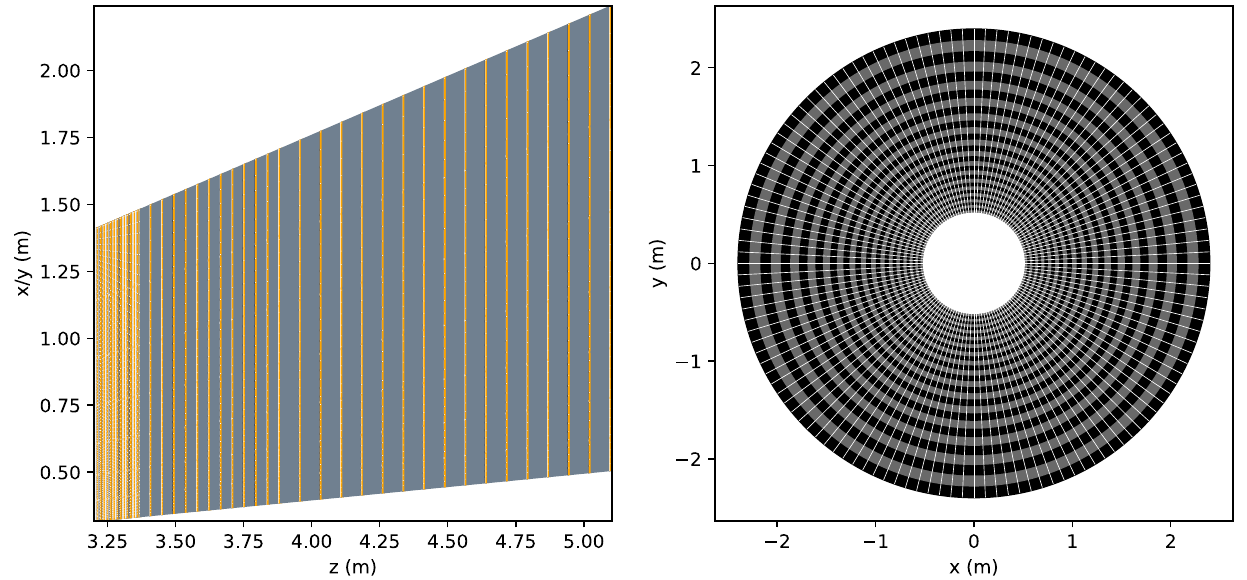
Fig. 2 Left: schematic representation of the detector longitudinal sampling structure. Right: transverse view of the last active layer. Different colors represent different materials: copper (orange), stainless steel and lead (gray), air (white) and active sensors made of silicon